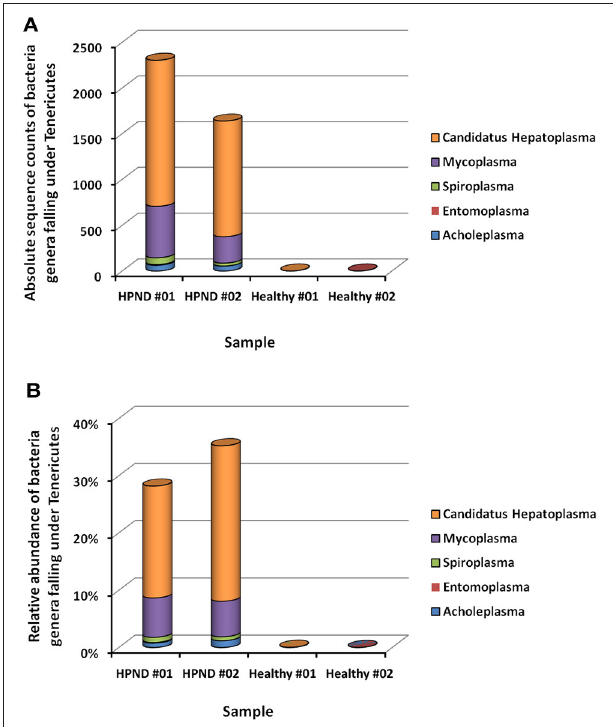
FIGURE 5 | Bacterial composition from Tenericutes at the genus level in crabs with and without HPND. (A) Comparison of absolute sequence counts for the major genera of Tenericutes in diseased and healthy crabs. (B) Comparison of the relative abundance of the major genera of Tenericutes in iseased and healthy crabs. HPND #01, HPND #02: two samples from crabs with HPND; Healthy #01, Healthy #02: two samples from crabs without HPND.